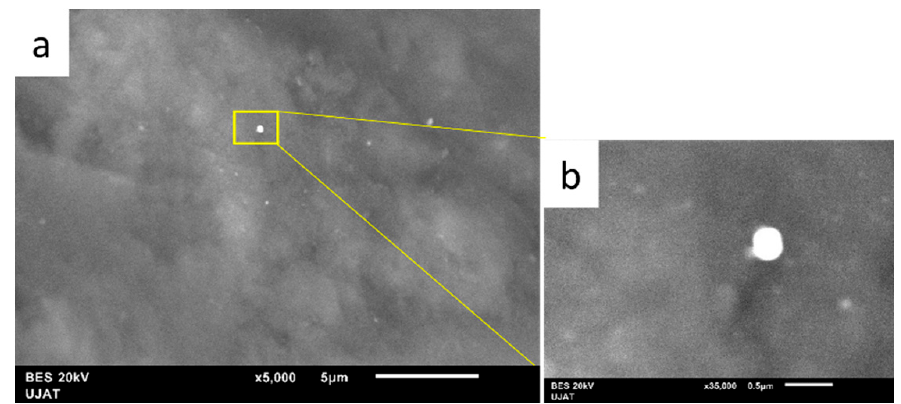
Figure 8. SEM images of NiCuAlCe bimetallic catalyst ( a ) 5000× and ( b ) 35000×. The EDS spectrogram in Figure 9 shows the presence of Ni and Cu in this sample, without any significant variation in the theoretical content of both metals (Ni (4.59 wt%) and Cu (4.86 wt%)).